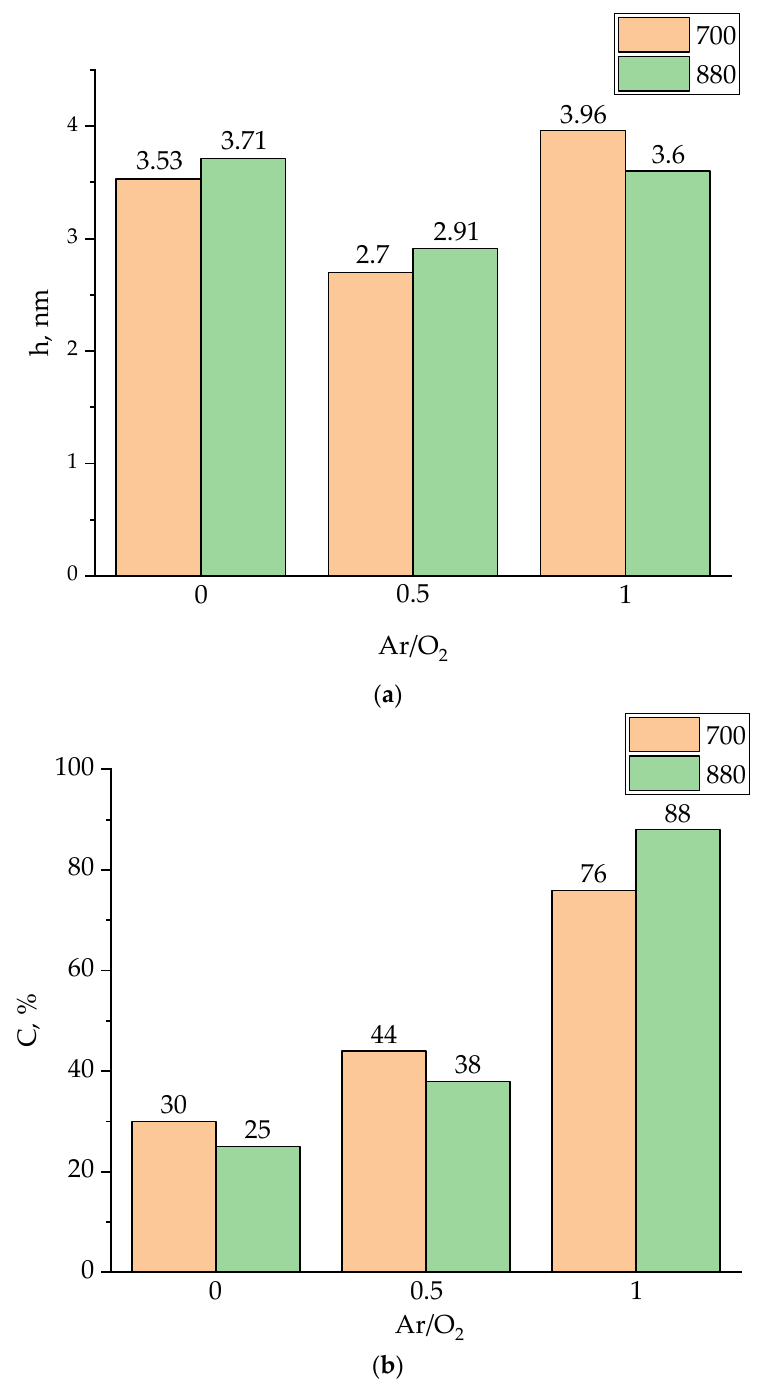
Figure 2. Dependence of the height of the islands h ( a ) and the area of substrate covered by film C ( b ) on the composition of the working gas at substrate temperatures of 700 °С and 880 °С.